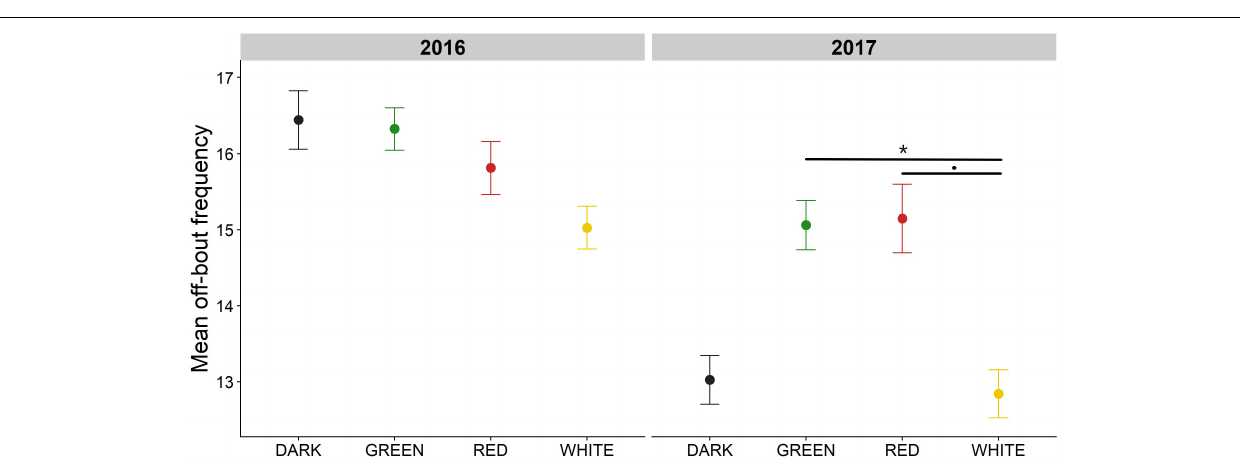
FIGURE 3 | Mean off-bout frequency (number of off-bouts per incubation day). Raw means +-SE are depicted for each artificial light treatment in two breeding seasons. Treatments only differed from each other in the breeding season of 2017 (right panel): females in the white treatment took significantly fewer off-bouts compared to the green treatment (estimate = − 2.1, z.ratio = − 2.90, P = 0.04), with a trend in the same direction compared to the red treatment (estimate = − 2, z.ratio = − 2.59, P = 0.08). The effect was independent of incubation period. * P < 0.05, ◦ P <